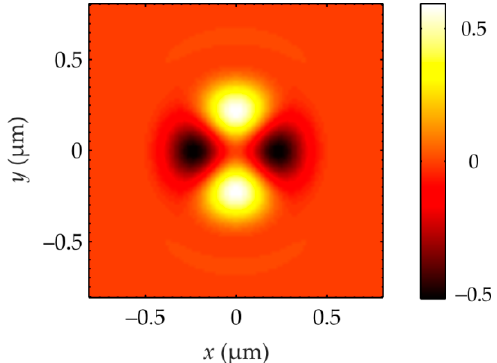
Figure 1. Distribution of the longitudinal SAM component, S z , calculated using Equation (5) at the focus of an aplanatic objective with NA = 0.95 illuminated by an optical vortex ( m = 1) with linear polarization along the x -axis.